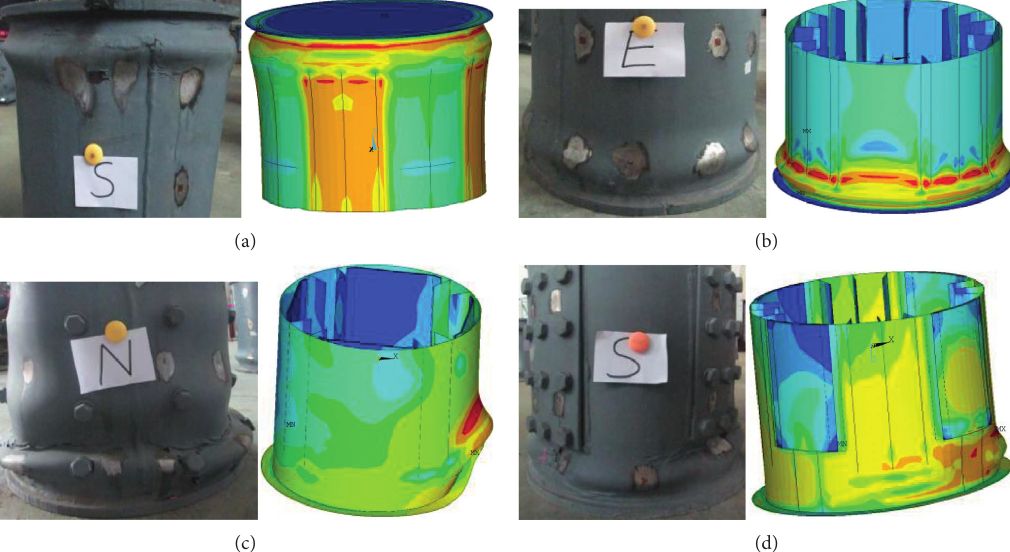
Figure 14: Comparison on failure modes of some axially compressed specimens. (a) Specimen II-A-1. (b) Specimen III-A-1. (c) Specimen III-C-2. (d) Specimen IV-A-3.